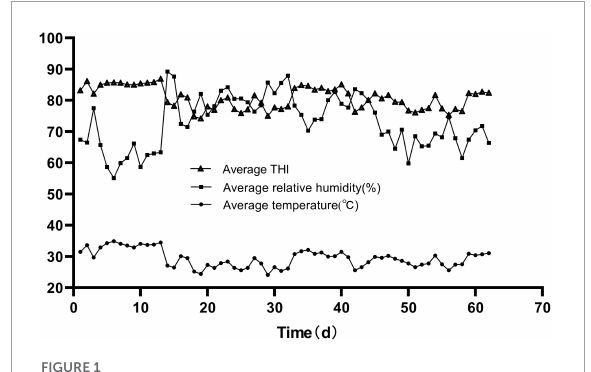
FIGURE1 The average temperature, average relative humidity, and THI during the trial period.